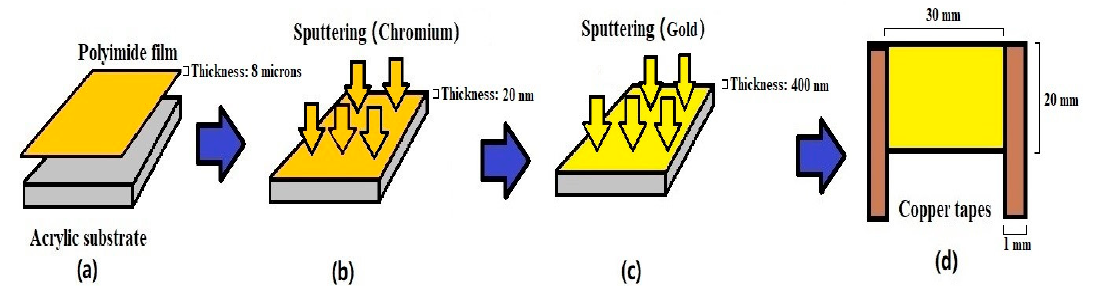
Figure 1. Schematic diagram of the steps of fabrication for the gold-polyimide sensors. ( a ) After attaching the polyimide films onto the acrylic dishes with tapes, ( b ) the thin-films were sputtered with chromium and gold to form the sensing area of the samples. ( c ), ( d ) The films were then taken off the template and attached to copper tapes on two sides to form the electrodes of the sensor patches.